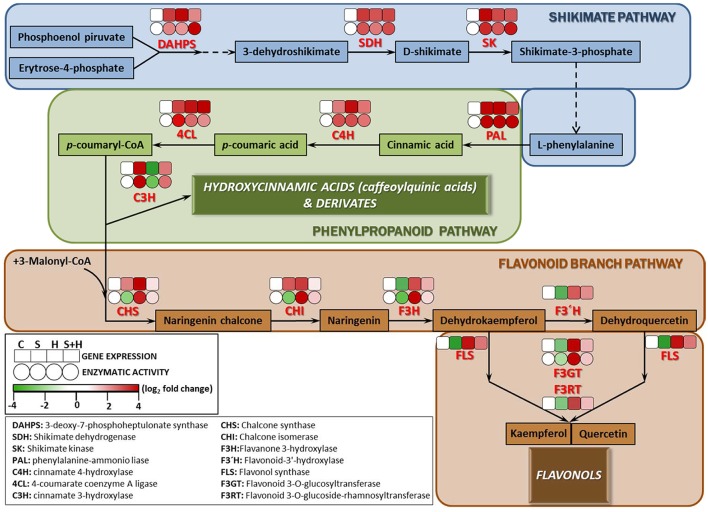
Scheme of the proposed changes in phenolic metabolism in tomato plants subjected to heat, salinity and a combination of heat and salinity. Differences in the activities (circles) of the enzymes involved in the phenylpropanoid pathway, and the expression (squares) of the transcripts that code for these enzymes under salinity, heat, and the combination of salinity and heat compared to control conditions are shown. A red color represents up-regulation, whereas green color shows down-regulation respect to the control treatment. Scale is the log2 of the mean (expression or activity) values after normalization against control plants (n = 6). Absolute activity values as well as log2 values of the enzymatic activities and transcript expression can be found in Tables S7–S9, respectively.